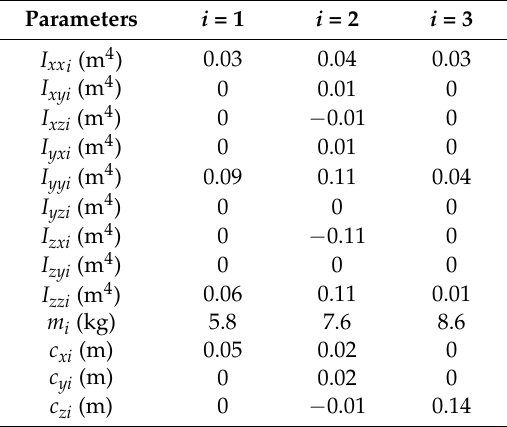
Table 1. Joint parameters of the